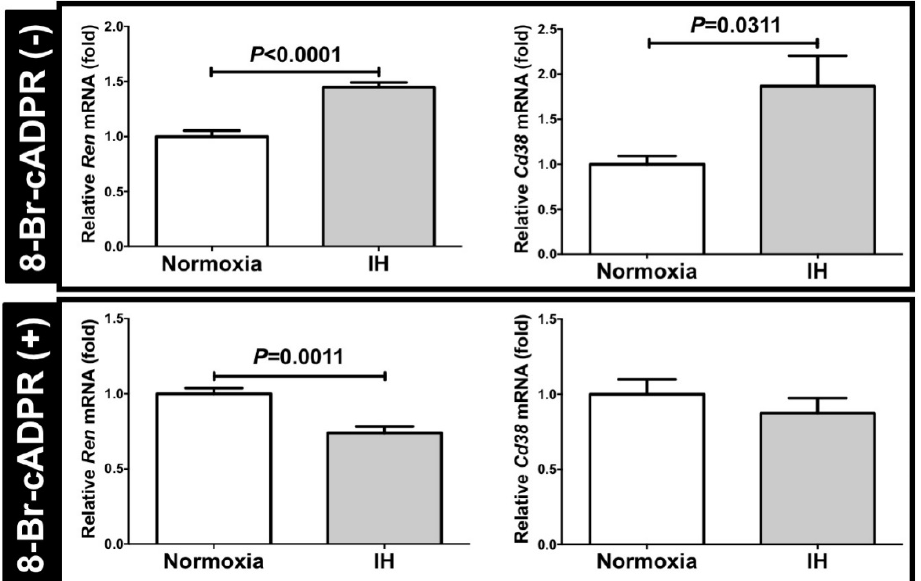
Figure 6. The mRNA levels of Ren and Cd38 with or without the addition of the 8-Br-cADPR. There is no difference in Ren mRNA between 8-Br-cADPR (-) group and 8-Br-cADPR (+) group (1.062-fold increase in 8-Br-cADPR (+), P = 0.604). In contrast, the Cd38 mRNA in 8-Br-cADPR (+) was increased 1.816-fold vs. 8-Br-cADPR (-) ( P = 0.0024). Although the mRNA levels of Ren and Cd38 were elevated in response to IH without the 8-Br-cADPR (8-Br-cADPR (-) controls), the elevation of the mRNAs the mean ± SE for each group of six independent experiments (n = 6). The statistical analyses were performed using a Student’s t -test.